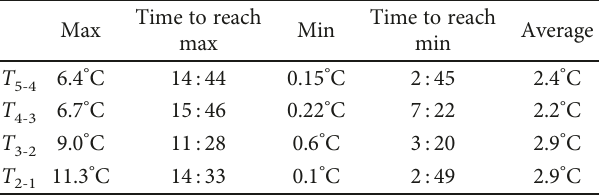
Figure 11: Temperature di ff erence between the nodes of the exterior air channel. Table 5: Summarized result of temperature di ff erence between nodes of the exterior air channel.